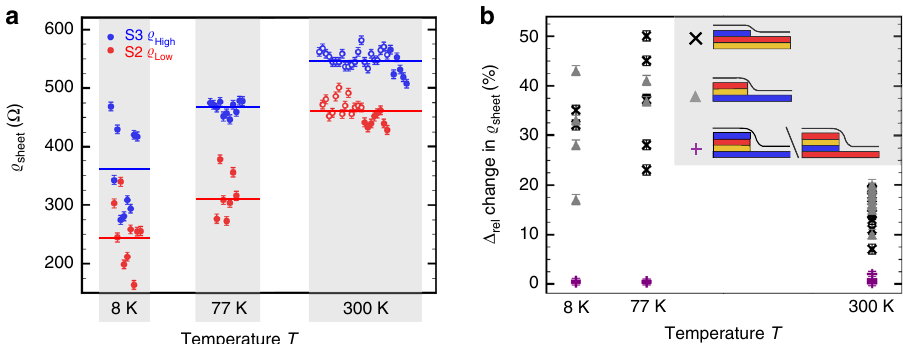
Fig. 2 Temperature-dependence of the sheet resistance. a Sheet resistance at 8 K, 77 K, and 300 K acquired on more than 80 terraces for two samples (indicated by open and fi lled symbols), solid horizontal lines indicate the mean value for a given terrace and temperature. b Change in sheet resistance for adjacent terraces for all three cases S3 → S2, S2 → S3, and S3 → S3/S2 → S2 as a function of temperature. Error bars indicate the experimental measurement uncertainty of the individual data points. Source data are provided as a Source Data fi le.